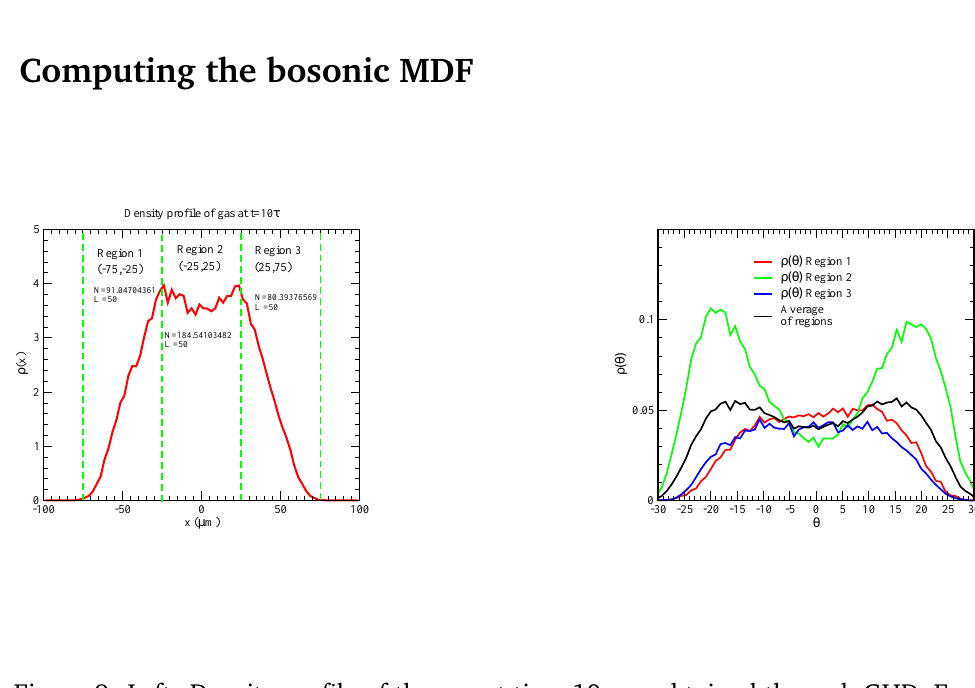
Figure 9: Left: Density profile of the gas at time 10 τ as obtained through GHD. For practical computations of the MDF, three regions are defined, each with character- istic root density function (see text). Right: Root density functions for each of the three regions defined in the left panel. Each curve is normalized to unit filling for